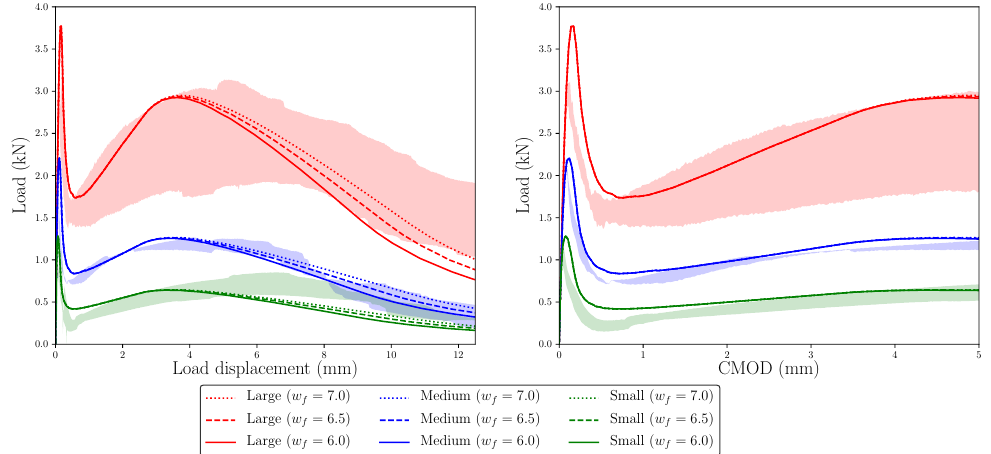
Figure 12. Numerical results compared with the experimental envelopes to study the influence of w f on the numerical simulations. The trilinear functions used in each case are shown in Figure 11. Experimental envelopes correspond to three specimens